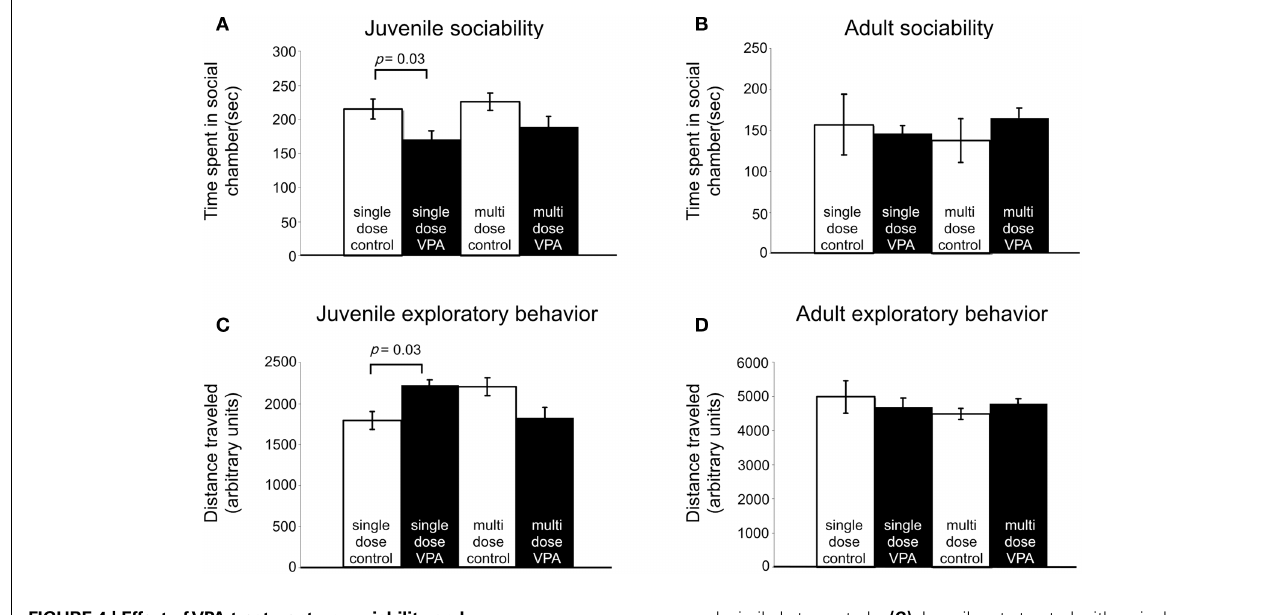
FIGURE 4 | Effect ofVPA treatment on sociability and exploratory behavior. (A) Juvenile rats treated with a single dose of VPA spend less time with a novel rat. (B) This effect is reversed in adults. Juvenile and adult rats treated with multiple doses ofVPA